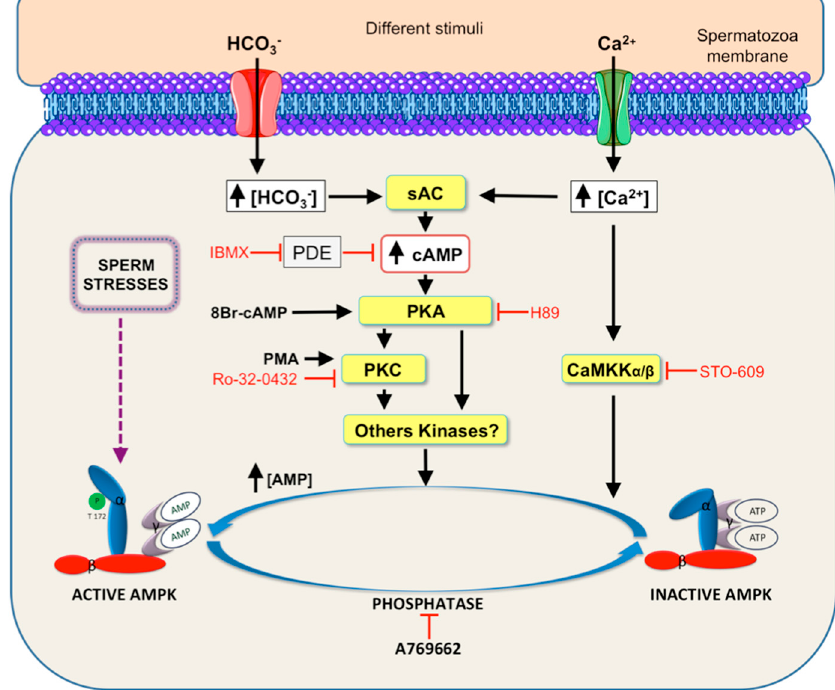
Figure 4. Signaling pathways underlying the regulation of AMPK activity in mammalian spermatozoa. This Figure summarizes the intracellular kinases and mechanisms that have been demonstrated to be involved in AMPK activation by Thr172 phosphorylation: soluble adenylyl cyclase (sAC), cAMP, protein kinase A (PKA), protein kinase C (PKC), intracellular Ca 2+ , calcium and calmodulin kinase kinases α / β (CaMKK α / β ) and different types of cell stresses detailed in the text (absence of Ca 2+ by BAPTA-AM, hyperosmotic stress, inhibition of mitochondrial activity). Pharmacological inhibitors of different AMPK upstream kinases (H89, IBMX, STO-609 and Ro-0432) are also indicated with red lines. Sperm AMPK phosphorylation is also stimulated by direct activation of PKC with